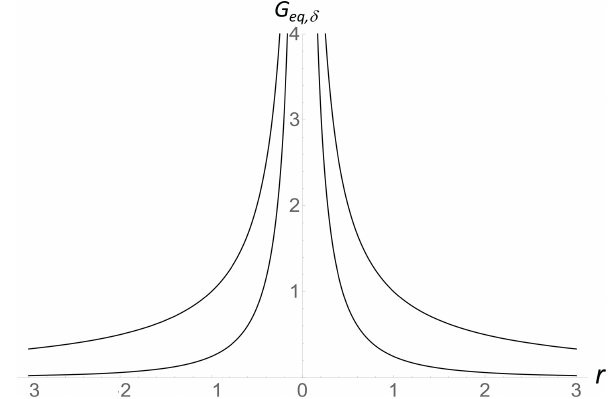
Figure 3. A comparison of the spatial impulse response Green’s functions for equilibrium with surface forcing via conduction only; (cid:12) ∂T eq (cid:12) = δ ( x ) with no radiation; top = r − 1 and bottom i.e., (cid:12) z = 0 ∂z the same but with conduction–radiative forcing via the surface (cid:18) (cid:12) ∂T eq (cid:12) + T ( r ; 0 ) = δ ( x ) BC (cid:12) z = 0 ∂z (Eq.